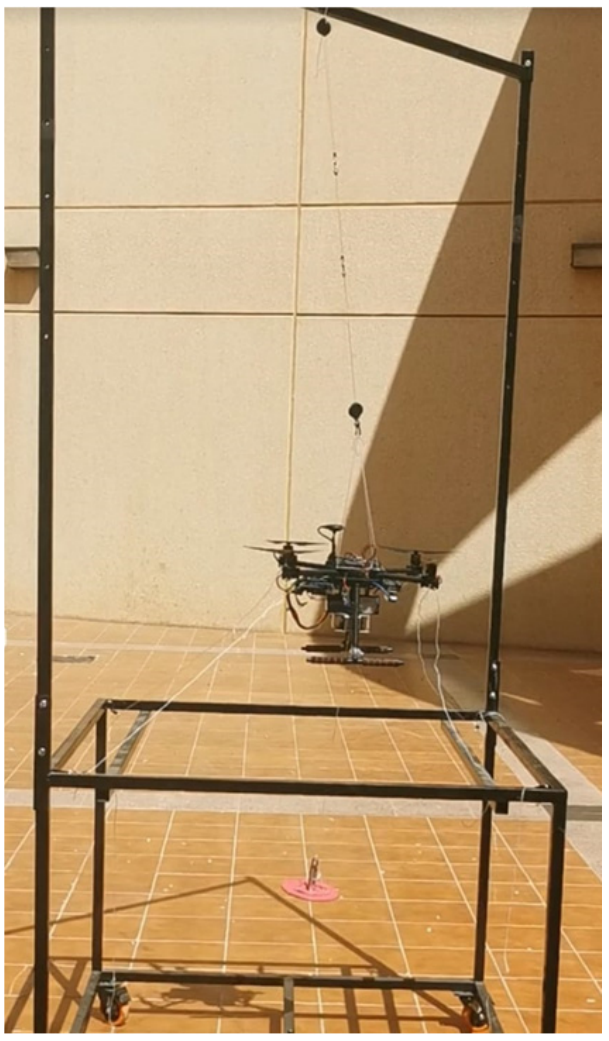
Figure 12. Restricted quadrotor with a suspended load in the test platform.